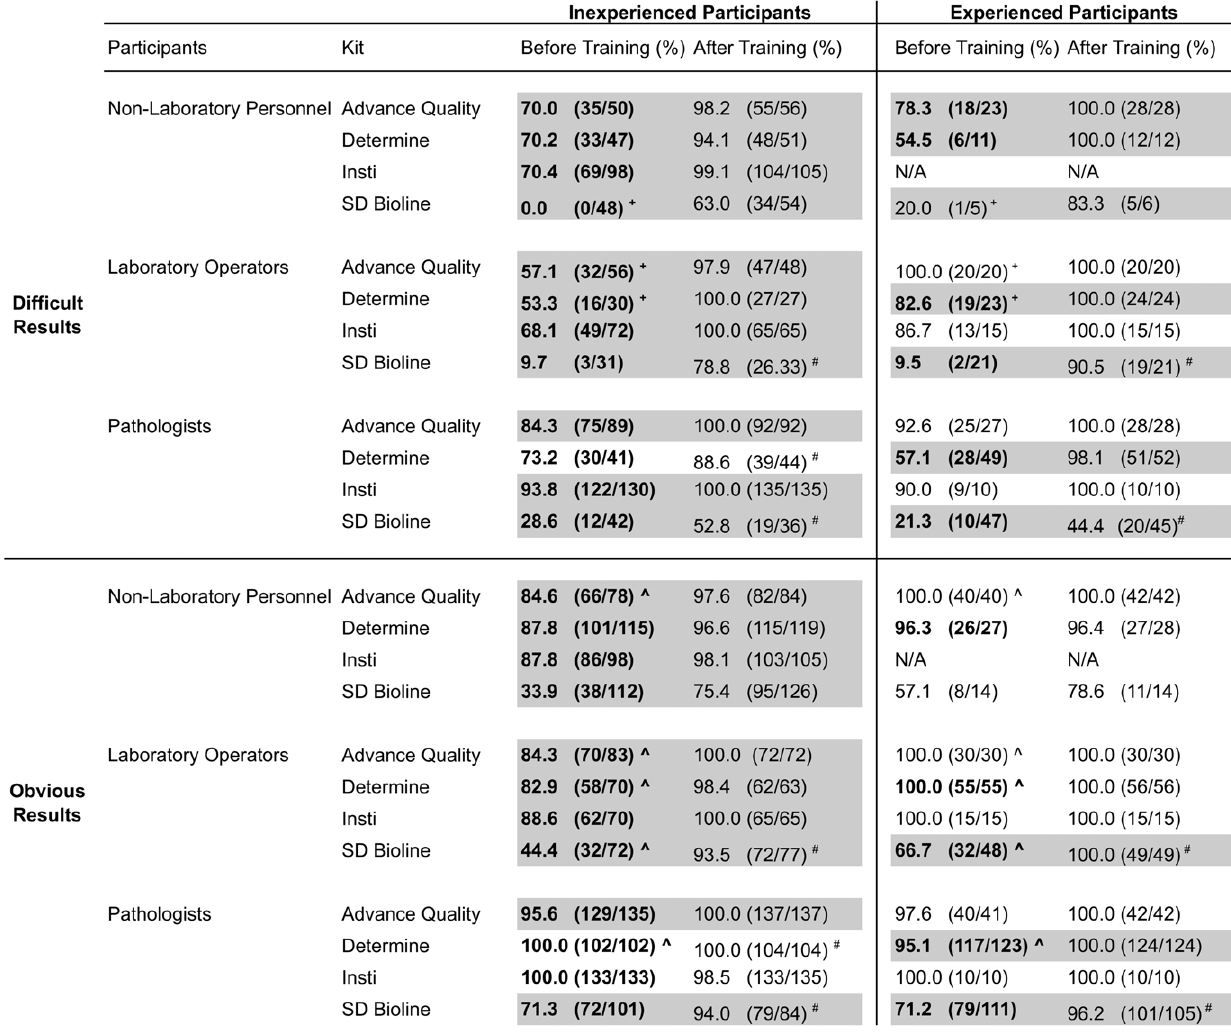
Figure 2. Interpretation accuracy of four rapid diagnostic test (RDT) kits by three groups of participants before and after training. The table is divided into four quadrants by the level of participants’ experience (inexperienced/experienced) and the difficulty of the RDT results (obvious/difficult). p , 0.05 from non-parametric Chi Square analysis is considered as significant difference. Grey block indicated the significant differences between before and after training. Bolded numbers indicated significant differences between difficult and obvious results before training. # indicated significant differences between difficult and obvious results after training. ‘ indicated significant differences between inexperienced and experienced participants for obvious results. + indicated significant differences between inexperienced and experienced participants for difficult results.